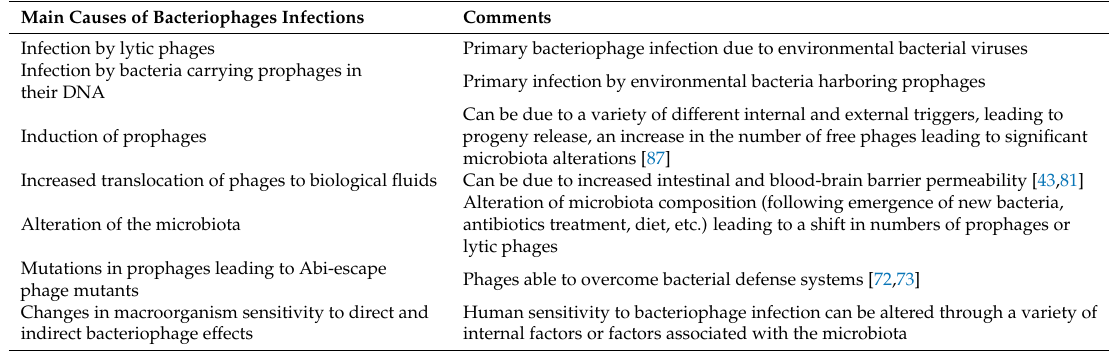
Table 1. Causes of bacteriophage